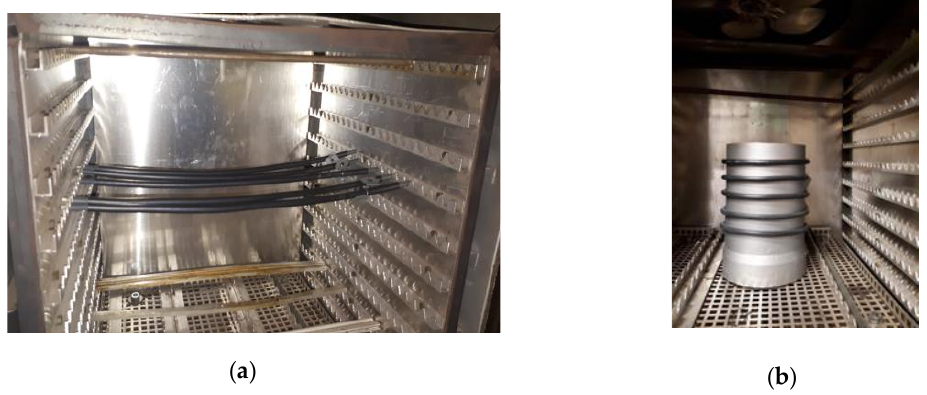
Figure 2. Cable samples in the oven for ( a ) thermal aging; ( b ) thermo-mechanical